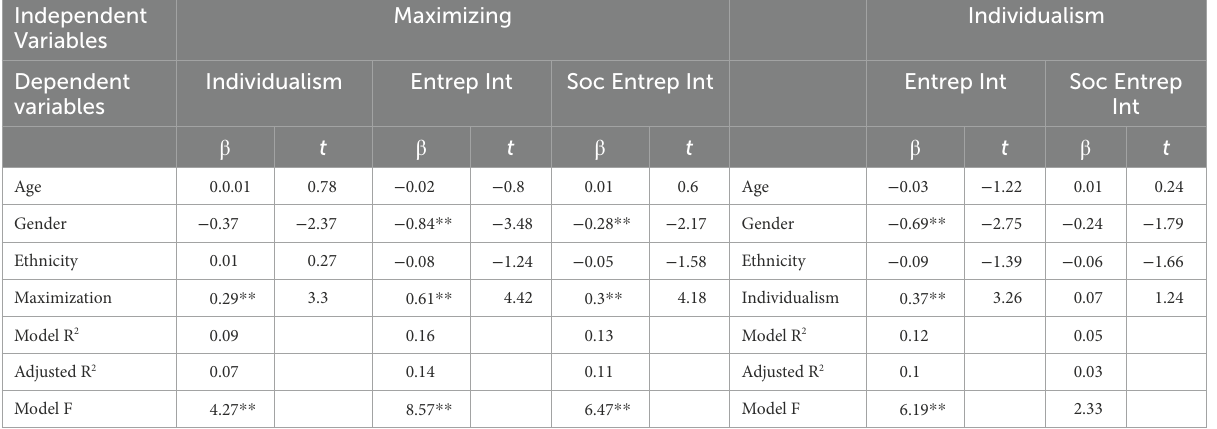
TABLE 2 Regression results for maximization and individualism. Independent Variables